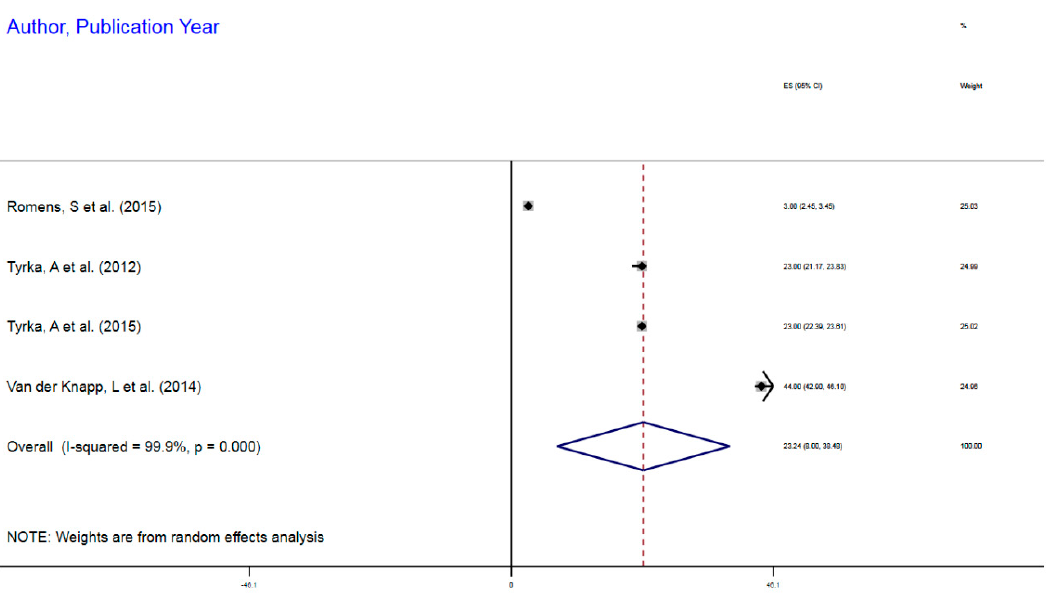
Figure 4. DNA Methylation of NR3C1 (glucocorticoid receptor gene) in Social Adversity with Early Life Stress